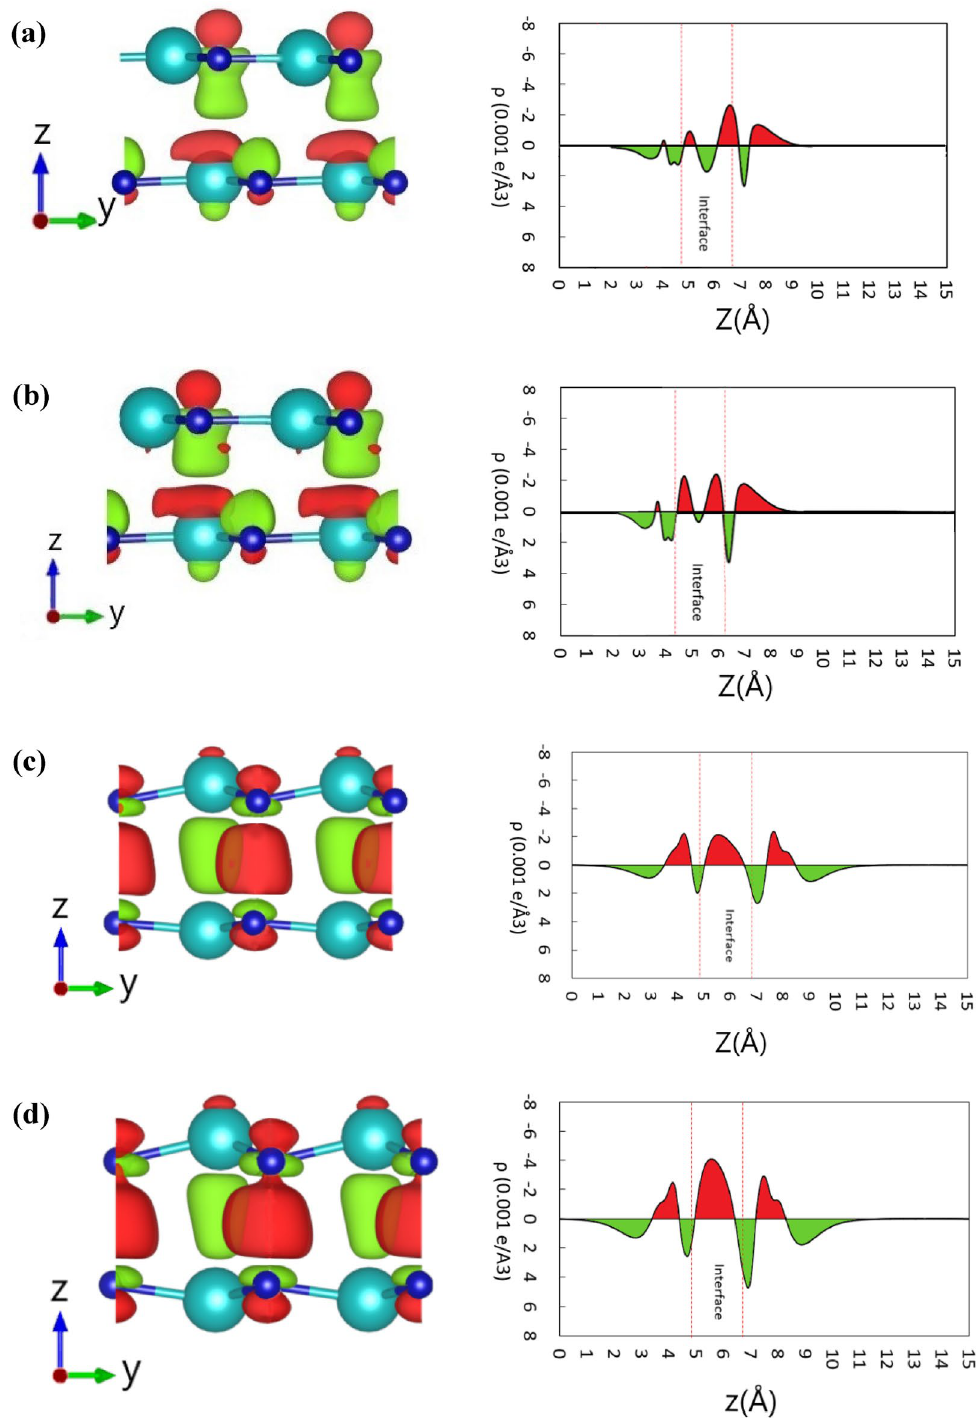
Figure 4. The charge density differences between the InN monolayers at 0.001 e/Å 3 . Here the upper two plots ( a , b ) refer to the A–B stacking pattern at an interlayer distance of 2.81 Å and 2.51 Å, respectively, and the lower two plots ( c , d ) refer to the A–A stacking pattern at an interlayer distance of 2.81 Å and 2.51 Å, respectively. Here, the red color refers to the charge accumulation, and the green color refers to the charge